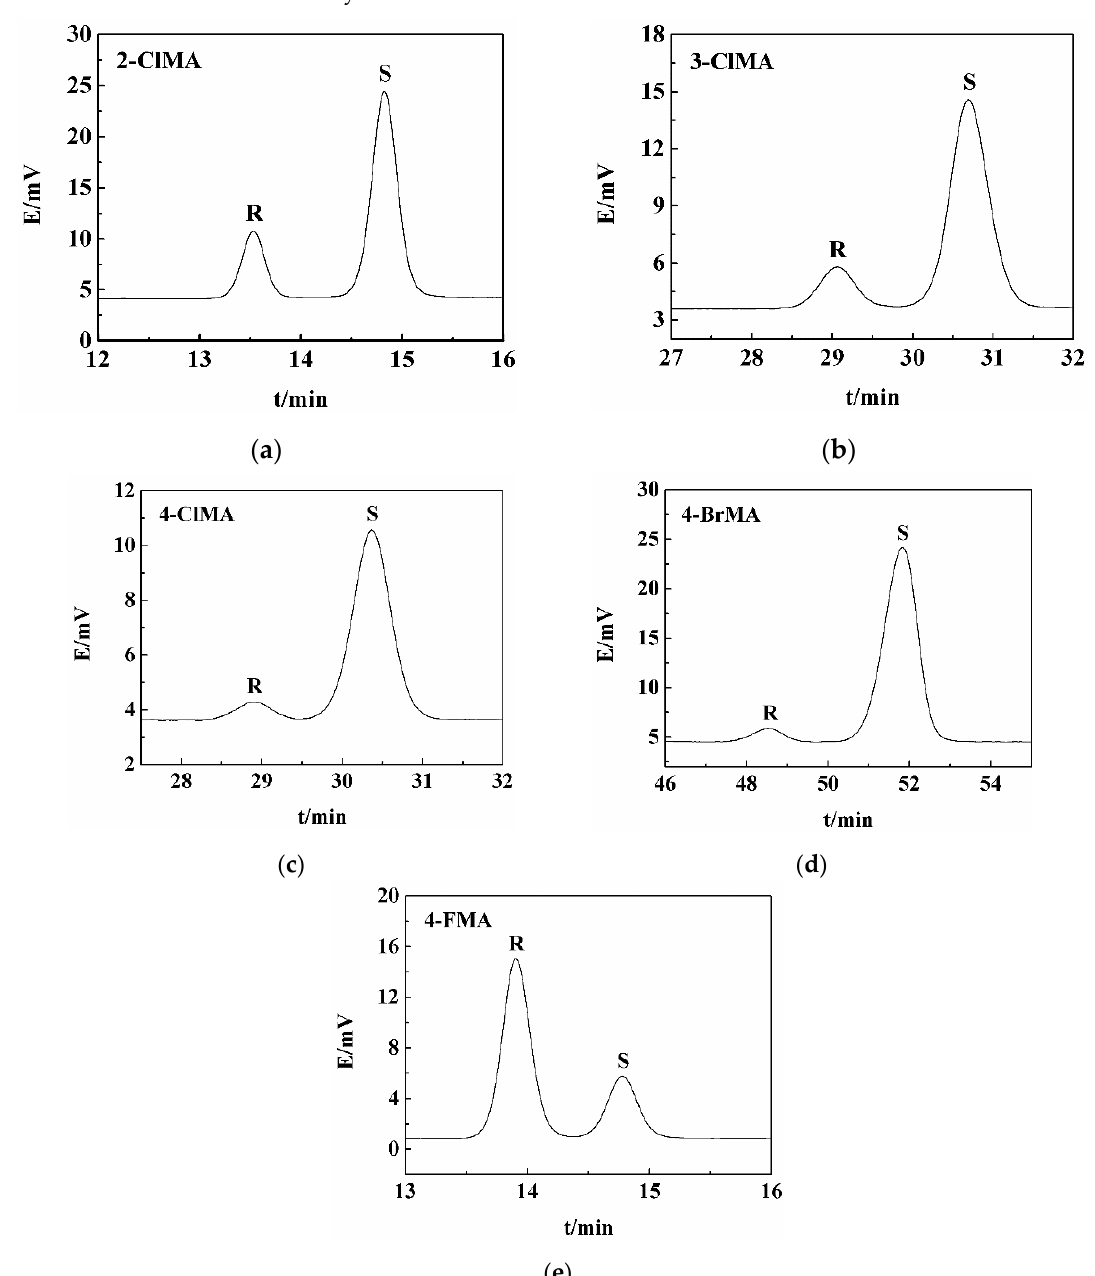
Figure 6. Typical liquid chromatograms of co-crystals obtained after resolving five halogenated mandelic acids with LEV: ( a ) 2-ClMA; ( b ) 3-ClMA; ( c ) 4-ClMA; ( d ) 4-BrMA; and ( e ) 4-FMA.